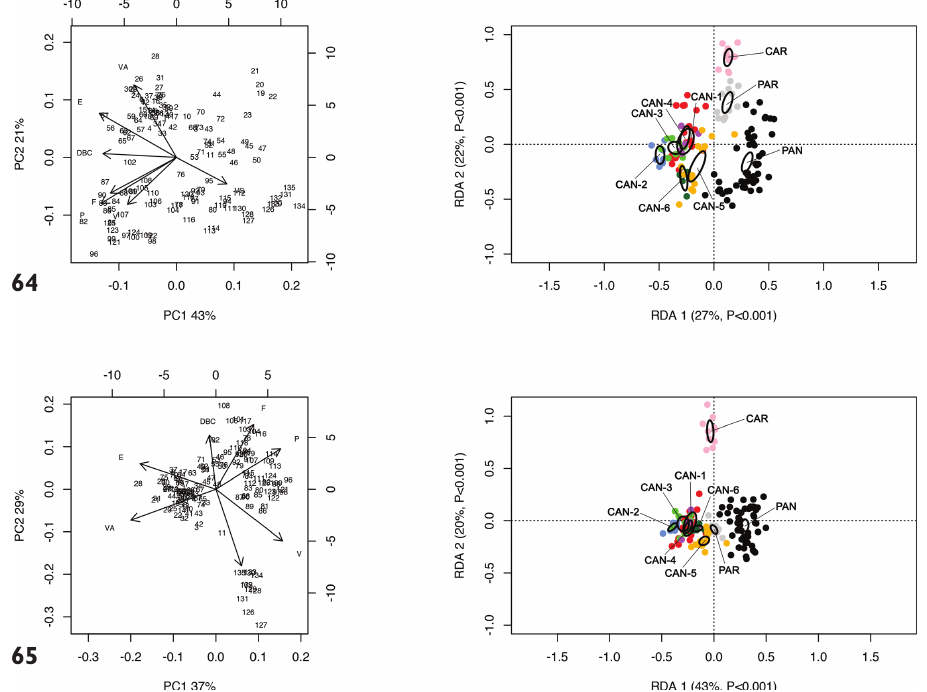
Figures 64, 65. Principal component analysis (PCA) and Redundancy analysis (RDA) with species